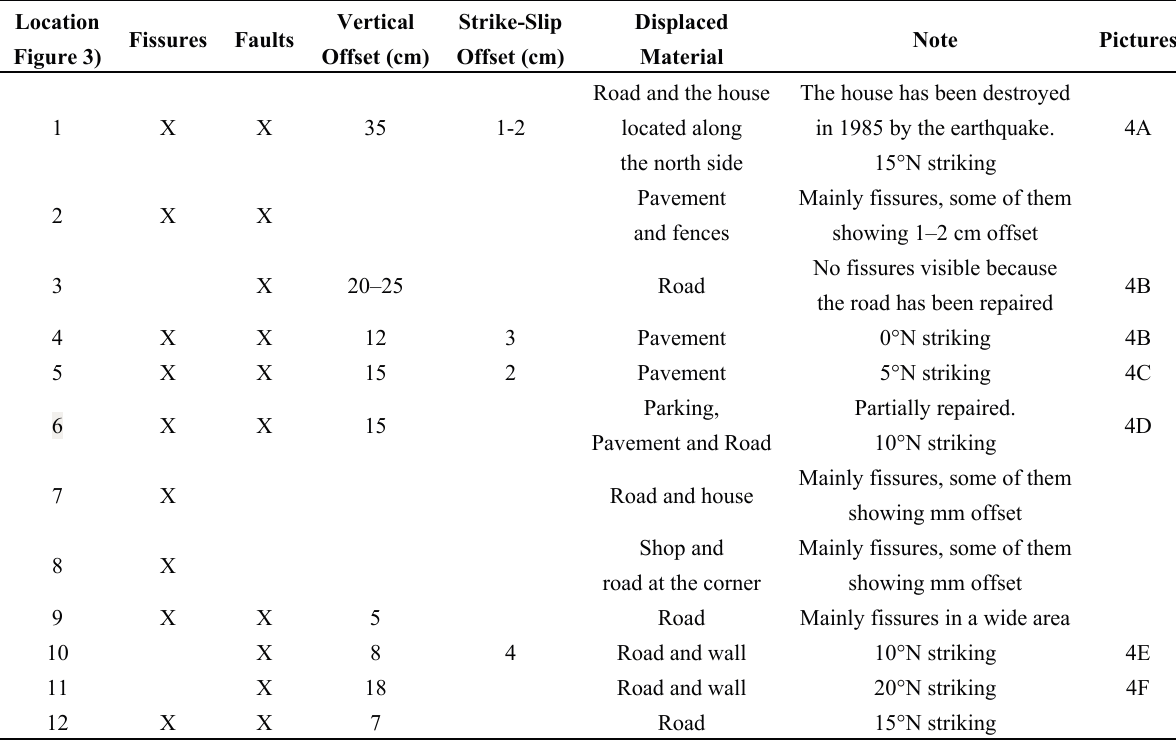
Figure 3. Main sites where faults and fissures affected Ciudad Guzmán on 21 September 2012. Numbers refer to the site described in Table 1. Representation on ESRI basemap imagery service. See Figure 2 to locate the area. Table 1. Faults and fissures in Ciudad Guzman produced in September 2012. Strike-slip offsets have right-lateral sense of